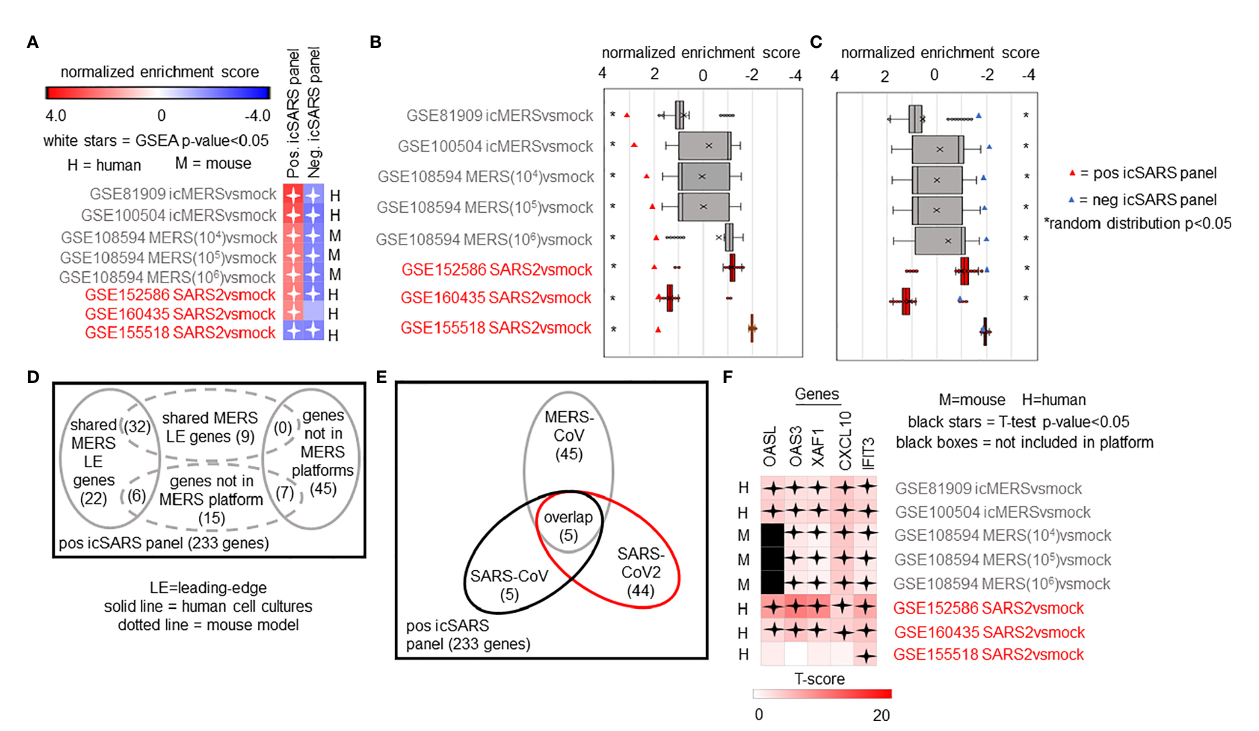
FIGURE 6 | Five Over-Expressed Genes Identi fi ed in SARS-CoV Meta-analysis Found in Meta-analysis of MERS-CoV and SARS-CoV2 Signatures. (A) Heat map of Gene Set Enrichment Analysis calculated normalized enrichment scores for positive and negative icSARS panels across gene signatures derived from MERS-CoV and SARS-CoV2 infections in human or mouse lung cultures. (B) Box and whisker plots of normalized enrichment scores from 1000 randomly generated gene panels containing 233 genes (individual queries) compared to MERS-CoV and SARS-CoV2 gene signatures (individual references). (C) Box and whisker plots of normalized enrichment scores from 1000 randomly generated gene panels containing 114 genes (individual queries) compared to MERS-CoV and SARS-CoV2 gene signatures (individual references). (D) Venn diagram of the inclusion and overlap of positive icSARS panel genes in identi fi ed leading-edges and dataset platforms across MERS- CoV human and mouse gene signatures. (E) Venn diagram of the inclusion and overlap of shared positive icSARS panel genes in identi fi ed in SARS-CoV ( Figure 6 ), MERS-CoV (from D), and SARS-CoV2 gene signatures. (F) Heat map of T − scores for the fi ve positive icSARS panel leading-edge genes identi fi ed in (E)